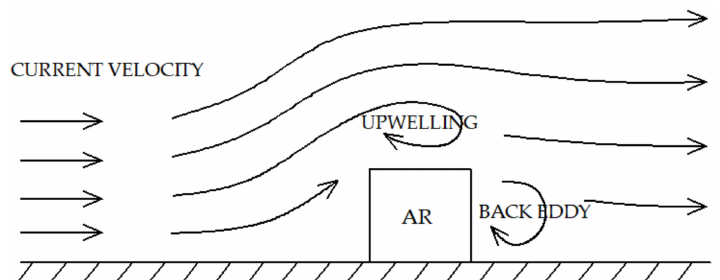
Figure 1. Usual velocity field around an